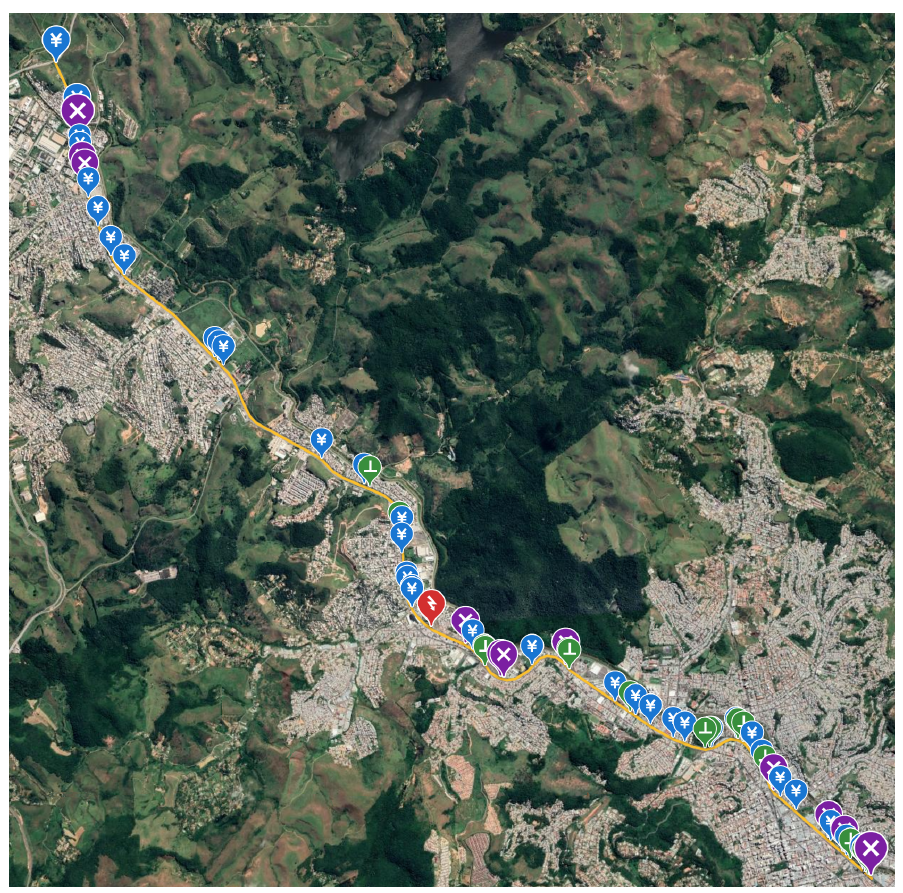
Figure 18. Batch Mission containing 50 POI with multiples elements with respective measured and filtered temperature.